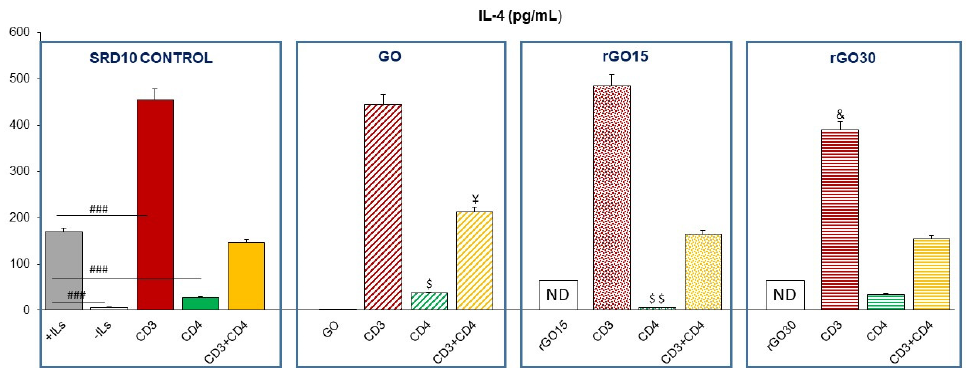
Figure 8. Effect of GO, rGO15 and rGO30 on interleukin-4 (IL-4) secretion by CD4 + Th2 SR.D10 cell line after 24 h of treatment with 5 µg/mL of these nanostructures, evaluated by ELISA under basal and stimulated conditions. The control cells were cultured in the presence of stimuli without material (SR.D10 CONTROL) in parallel. Statistical significance: ### p < 0.005 (compared to control cells without material cultured in the absence of ILs); & p < 0.05 (compared to control cells activated through CD3 in the absence of ILs); $ p < 0.05; $$ p < 0.01 (compared to control cells activated through CD4 in the absence of ILs); ¥ p < 0.05 (compared to control cells activated through CD3 and CD4 in the absence of ILs).